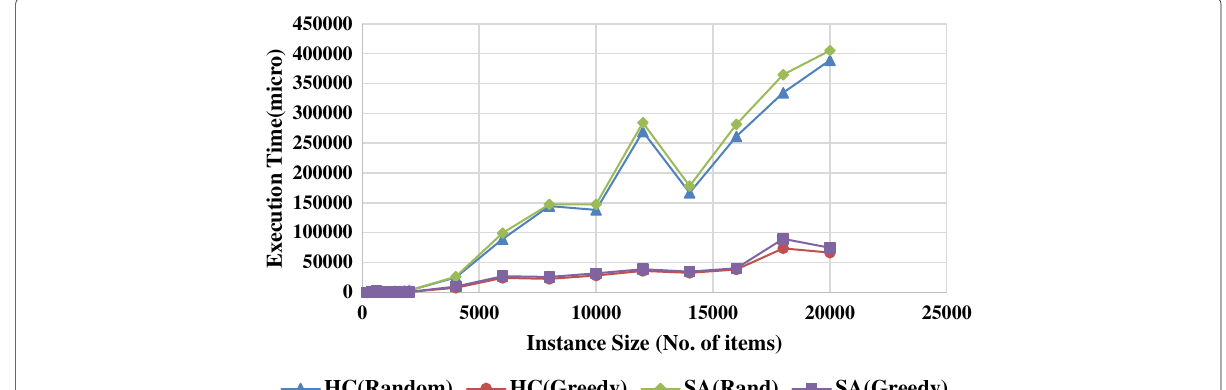
Fig. 11 Computational Effort for a large instance